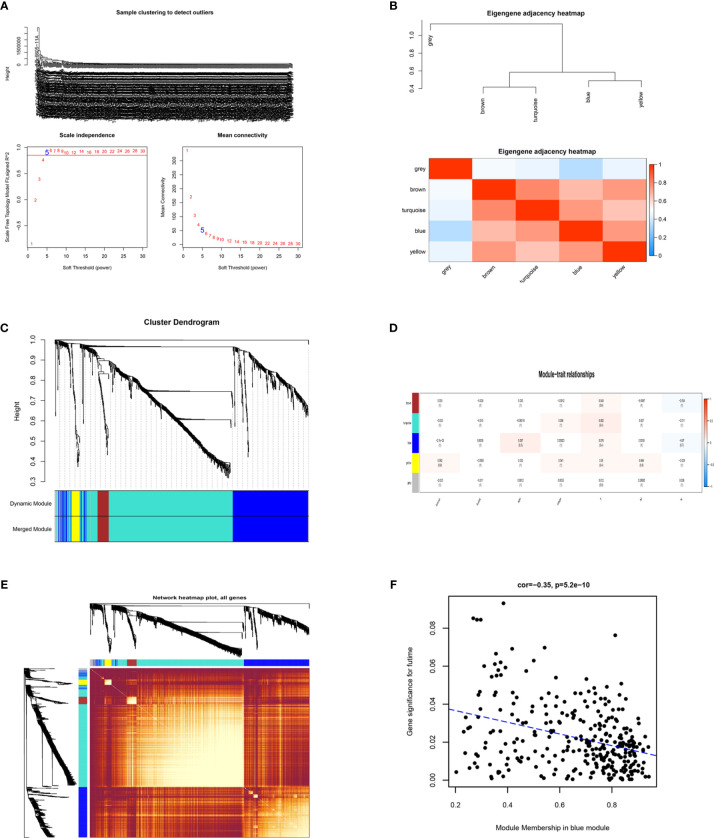
Identification of key modules correlated with clinical traits in the The Cancer Genome Atlas (TCGA)-COAD and TCGA-READ datasets through Weighted Gene Co-Expression Network Analysis (WGCNA). (A) Clustering dendrograms of genes. Analysis of the scale-free fit index (left) and the mean connectivity (right) for various soft-thresholding powers. (B) Clustering of module eigengenes and a heatmap of adjacent eigengenes. (C) Dendrogram of all differentially expressed genes (DEGs) clustered from TCGA based on a dissimilarity measure. (D) Heatmap of the correlation between module eigengenes and clinical traits of colorectal cancer (CRC). Each cell contains the correlation coefficient and P value. (E) TOM network heatmap of all genes. (F) Scatter plot of module eigengenes in the blue module. The genes in the blue module with significance in futime.